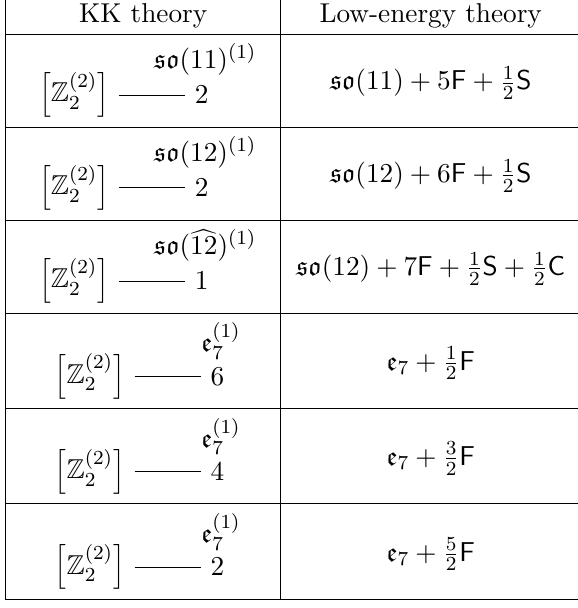
Table 3 . Low-energy 5 d non-abelian gauge theories associated to 5 d KK theory building blocks involving twists of second type. C denotes the conjugate spinor representation of so (2 n ) and F for e 7 denotes the 56 dimensional irreducible representation of e 7